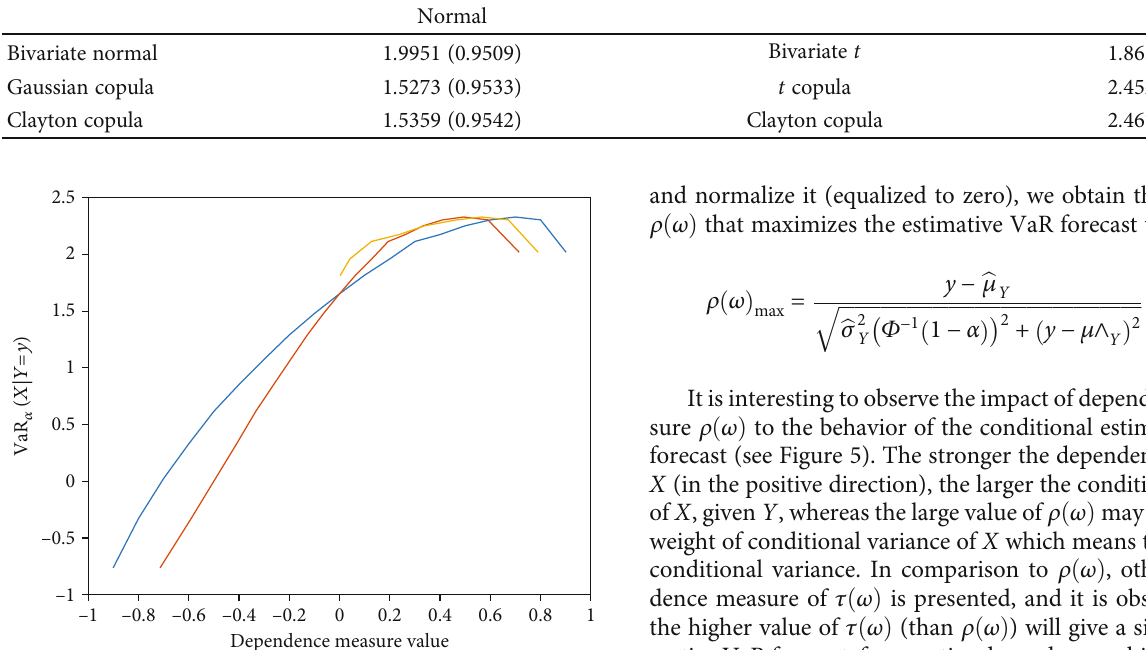
Figure 5: Conditional estimative VaR forecast, for bivariate normal distribution, against dependence measure ρ ð ω Þ (blue line), compared to other dependence measures of τ ð ω Þ (brown line) and λ U ð ω Þ (yellow line); − 1 ≤ ρ ð ω Þ , τ ð ω Þ ≤ 1 ; 0 ≤ λ U ≤ 1 :